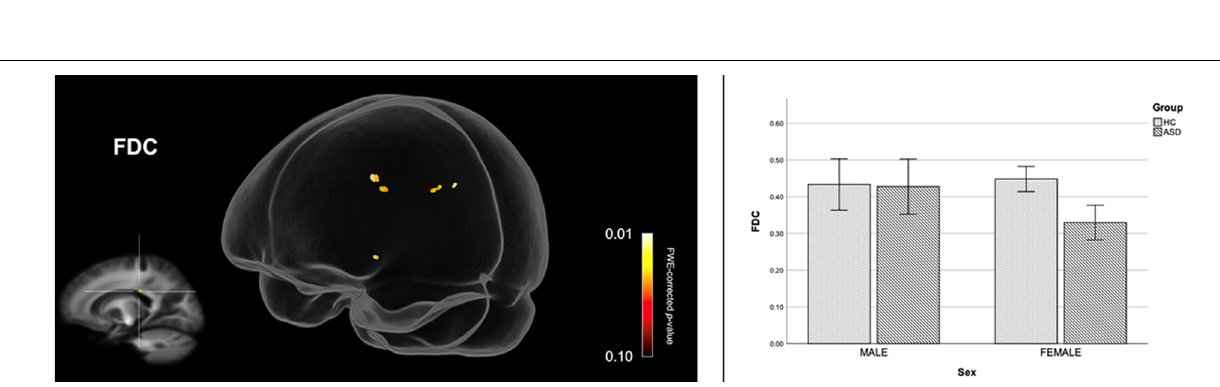
FIGURE 2 | Reduced fiber density and cross-section (FDC) in females with ASD (compared to females in the control group). Streamline segments were cropped from the whole brain tractogram to include only streamlines that traversed fixels showing significantly reduced FDC in females with ASD ( p < 0.05, FWE corrected). Bar graphs represent mean FDC in each group. Mean FDC was computed for each participant across all fixels showing reduced FDC in females with ASD ( p < 0.05, FWE corrected). Error bars represent 95% confidence intervals. FWE = family-wise error; HC = healthy